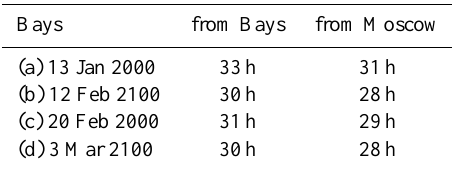
Table 8. Around the world travel times at Moscow (1958). Bays from